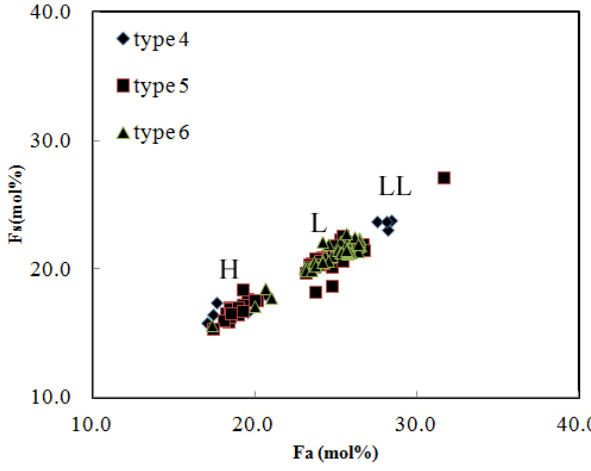
Figure 3. Fa of olivine and Fs of low ‐ Ca pyroxene of 184 chondrites.